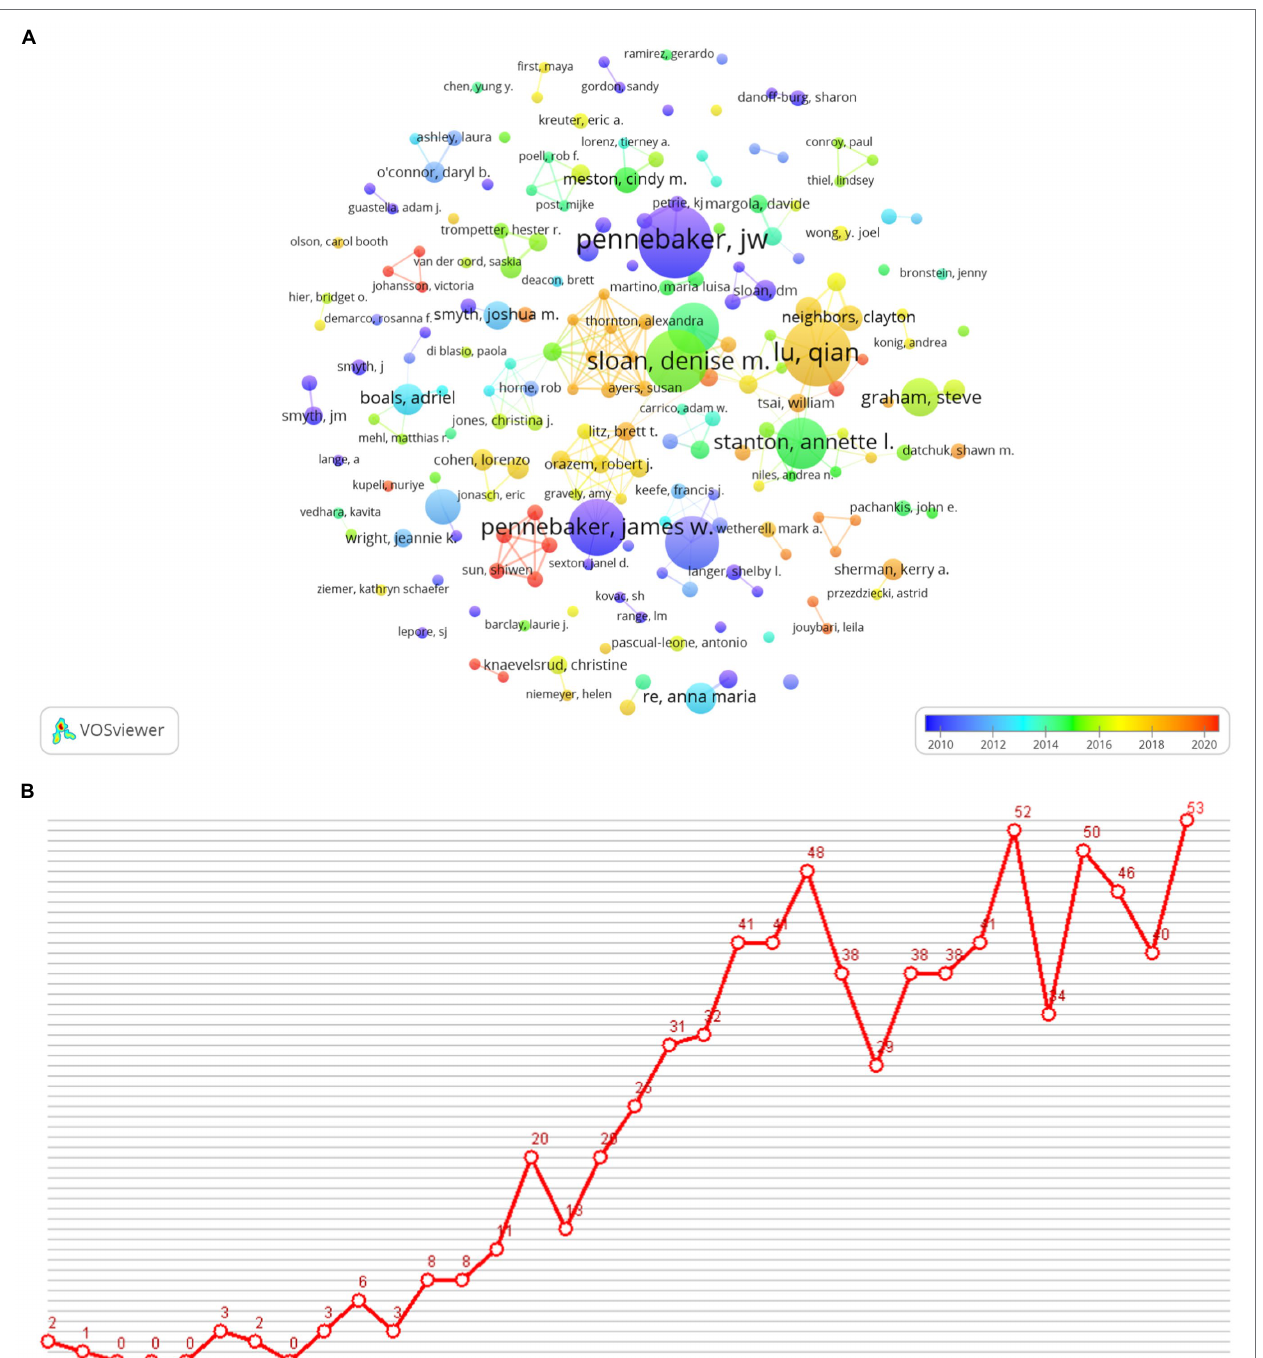
FIGURE 4 | (A) Author cooperation network in expressive writing. In co-authorship function, the minimum number of documents of an author was set 3. A total of 197 authors met the thresholds and appeared in the map. When setting five items as the minimum cluster size, there were 83 clusters of author cooperation networks with the biggest network including 14 authors. (B) Author citation history graph of James